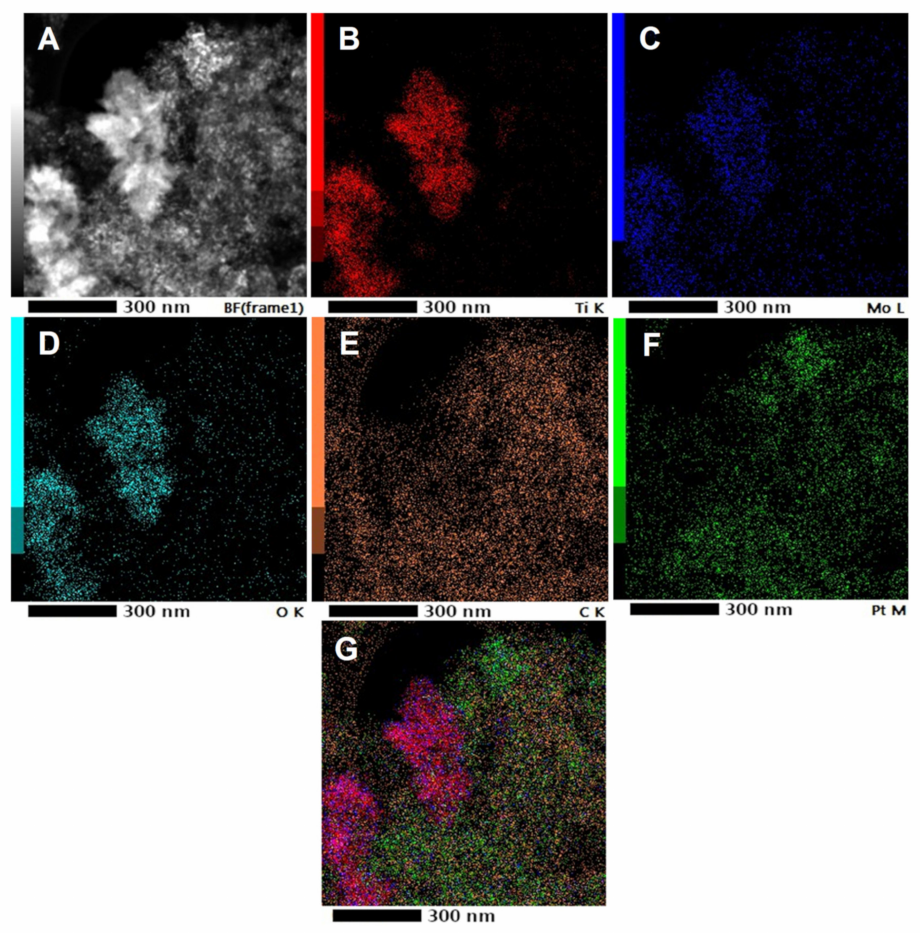
Figure 4. Elemental maps of the Pt/75BP electrocatalyst. HAADF STEM micrograph ( A ), Ti ( B ), Mo